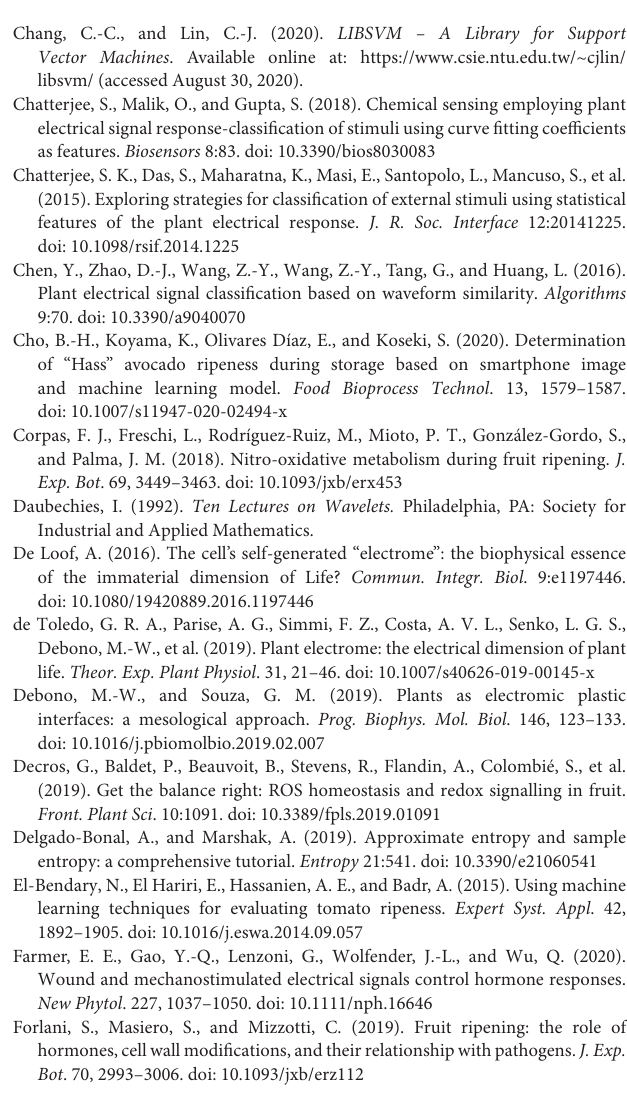
Supplementary Figure 1 | Time series of electrical signals acquired during ripening process of cherry tomatoes. (A) Mature green fruit, (B) breaker fruit, (C) light red fruit. volt [ 1 V (mV)] by time